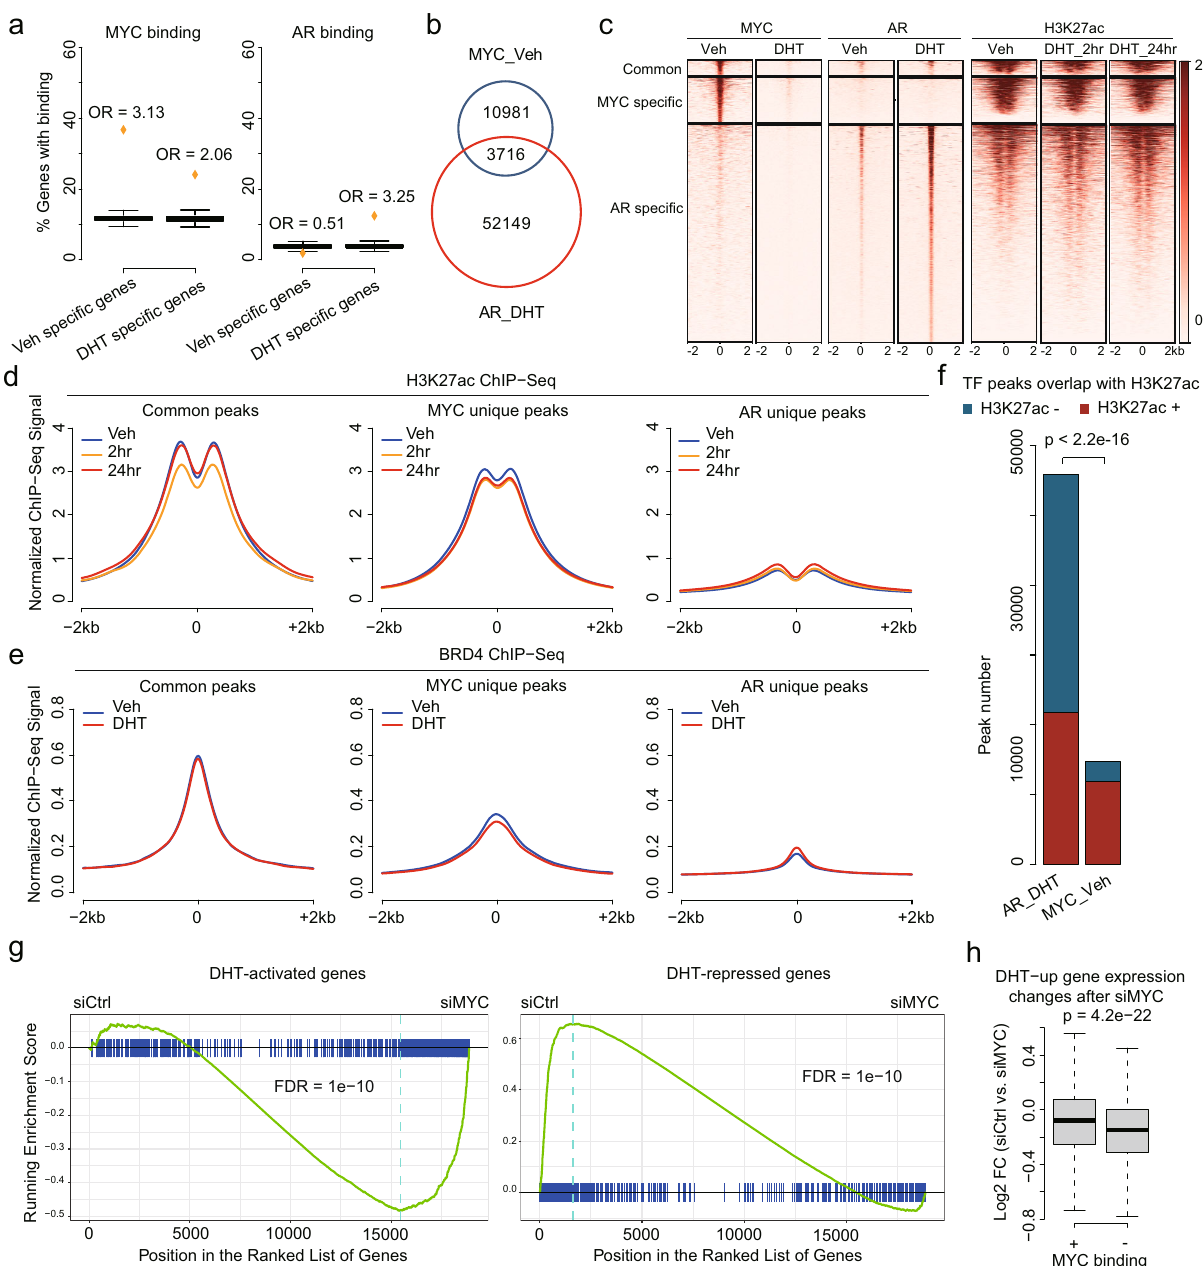
Fig. 3 Functional interaction between MYC and AR proteins. a Enrichment analysis of vehicle-speci fi c or DHT-speci fi c genes with MYC or AR ChIP-seq peaks in proximity to (±20 kb) the TSSs. Orange points represent actual vehicle-speci fi c or DHT-speci fi c gene sets. Boxes represent 1,000 times random sampling from the whole transcriptome. Same number of genes as in the vehicle-speci fi c and DHT-speci fi c gene sets were used for random sampling, respectively. Odds ratio (OR) was calculated by comparing the percentage between actual gene sets and the average of random sampling. From the left to the right, P < 2.2e-16, P < 2.2e-16, P = 1 and P < 2.2e-16, respectively, by one-sided Student ’ s t test. Box limits, 1st and 3rd quartiles; whiskers, 1.5× inter- quartile range; center line, median. From the left to right, n = 1292, 1212, 1292, and 1212, respectively. b Venn diagram showing the overlap between MYC ChIP-seq peaks under vehicle condition and AR ChIP-seq peaks under DHT condition in VCaP cells. The MYC peaks overlapping with AR peaks are counted as common peaks. c Heatmaps showing the ChIP-seq signal of MYC, AR, and H3K27ac at MYC/AR common peaks, MYC-speci fi c peaks, and AR- speci fi c peaks in VCaP cells with or without DHT. d Pileup of H3K27ac ChIP-seq signal at MYC/AR common peaks, MYC-speci fi c peaks, and AR-speci fi c peaks in VCaP cells with or without DHT. e Pileup of BRD4 ChIP-seq signal at MYC/AR common peaks, MYC-speci fi c peaks and AR-speci fi c peaks in VCaP cells with or without DHT. f Barplot showing the number of liganded-AR and MYC peaks overlapping with enhancers (as marked by H3K27ac) in VCaP. The P value was determined by Chi-squared test. g Gene Set Enrichment Analysis (GSEA) using DHT-activated genes and DHT-repressed genes as gene sets to determine whether these two gene sets were regulated by MYC in complete FBS medium. h Boxplot showing log2 fold changes (siCtrl vs. siMYC) in complete FBS medium of DHT-upregulated genes. These genes were separated into two groups based on MYC binding status. Box limits, 1st and 3rd quartiles; whiskers, 1.5× inter-quartile range; center line, median. From the left to right, n = 392 and 216, respectively. P value was determined by two-sided Wilcoxon rank-sum